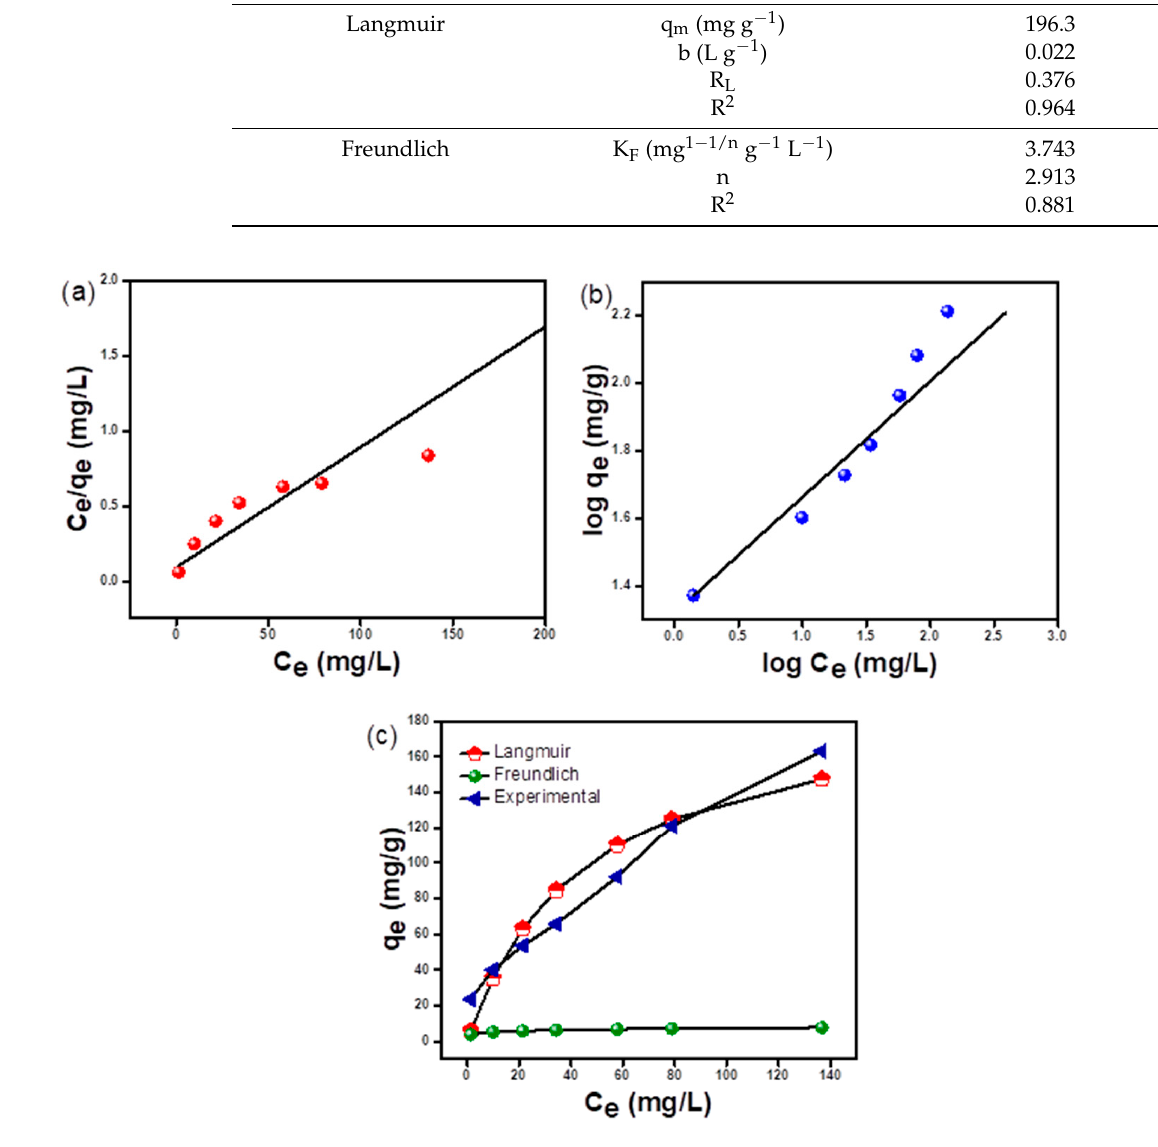
Figure 10. RO 16 adsorption isotherm curves of m-CGPA ( a ) Langmuir isotherm model curve ( b ) Freundlich isotherm model curve ( c ) Best fitted isotherm curve. Table 2. Adsorption isotherm parameters of m-CGPA for RO 16 dye adsorption. Model